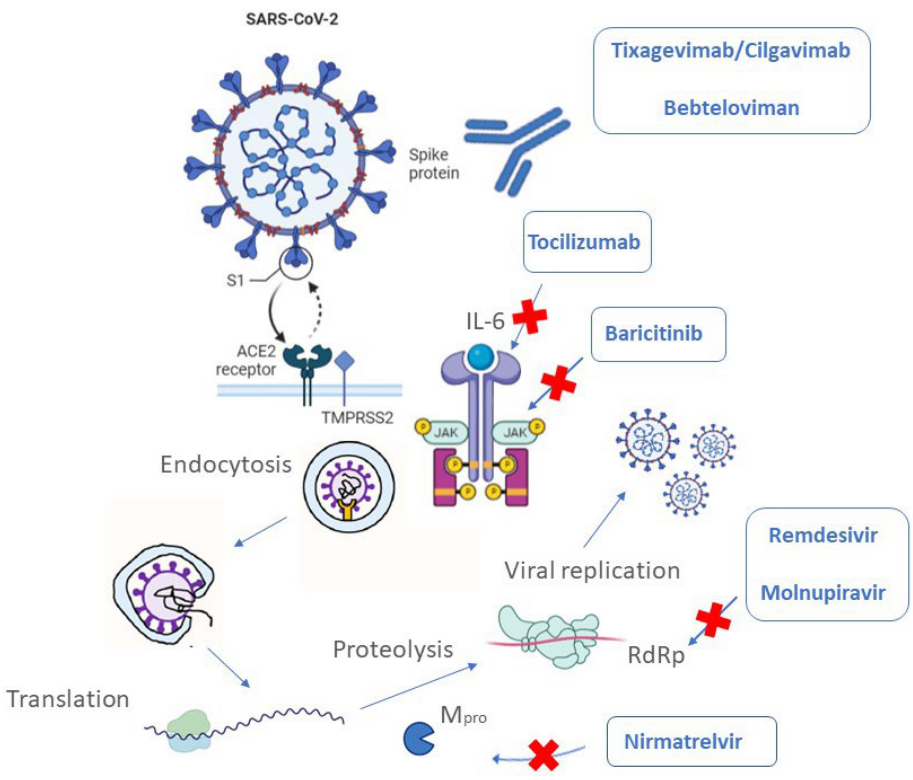
Figure 1. An illustrative picture showing the drugs approved in COVID-19 therapy and their related targets.